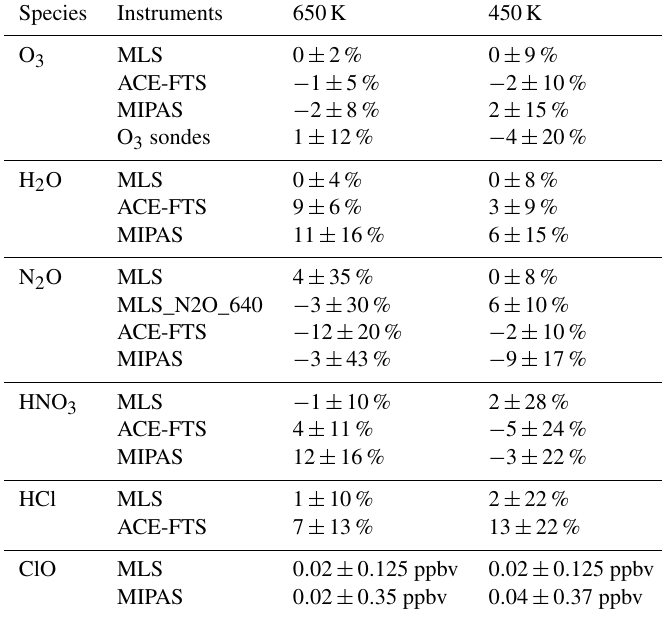
Table 2. Mean difference and standard deviation between BRAM2 and observations in the Antarctic inner vortex (between 90 and 75 ◦ of equivalent latitude) at 650 and 450K of potential temperature and between June and November of the 2005–2017 period. Values in percent are relative to BRAM2. Abbreviations: not assimilated (N.A.) and not observed